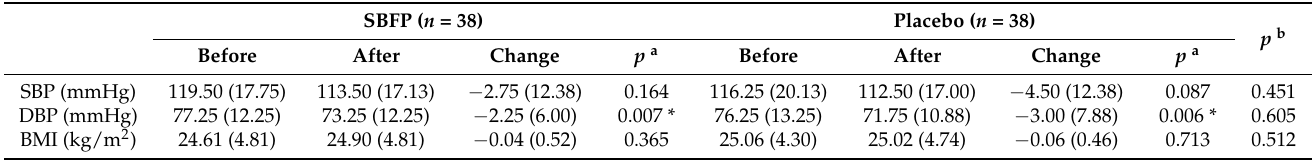
Table 6. Effects of SBFP and placebo on physical examination indicators.